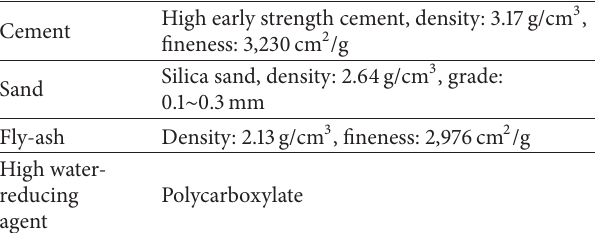
Table 3: Material properties for cement